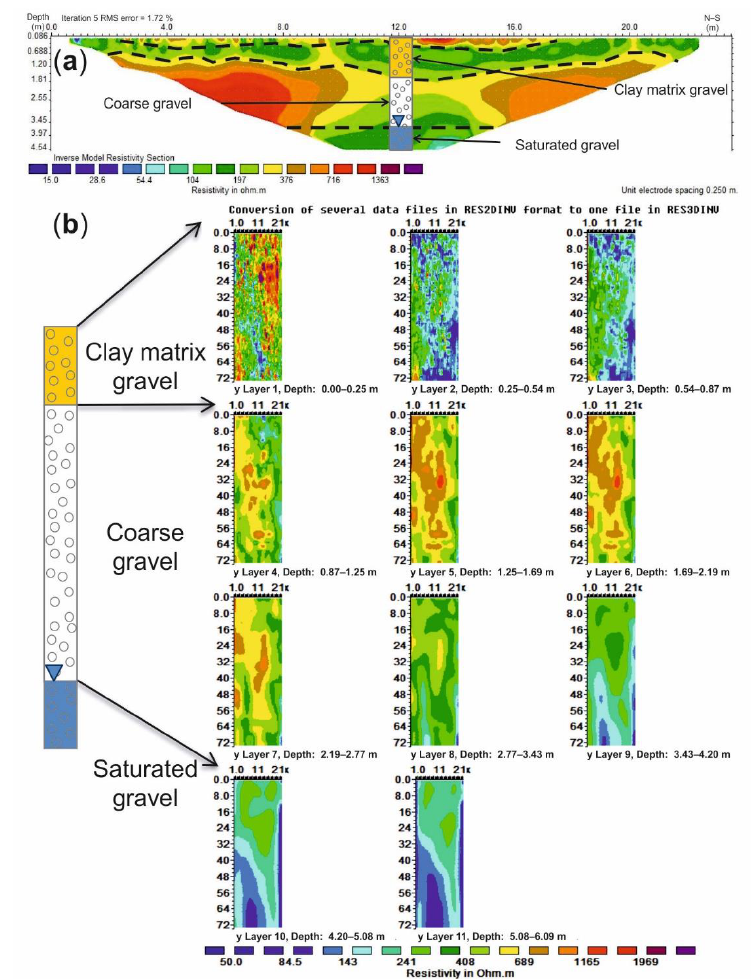
Figure 7. ( a ) Typical high-detailed 2D ERT cross-section and its hydrogeological interpretation obtained within the Ca n’Albareda infiltration pond. ( b ) Correlation of the piezometer CA2 with the electrical resistivity depth-slides obtained from the inversion of the 38 high-detailed 2D ERT